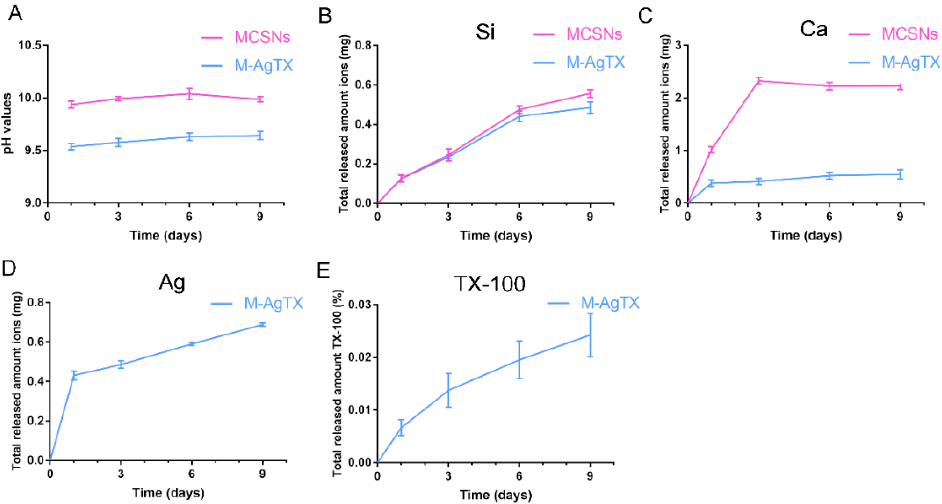
Figure 4. pH and release profile of MCSNs and M-AgTX. ( A ) pH curve of MCSNs and M-AgTX; ( B , C ) Total released amount of SiO 32 − , Ca 2+ of MCSNs and M-AgTX, respectively; ( D , E ) Total released amount of Ag + and TX-100 of M-AgTX, respectively.